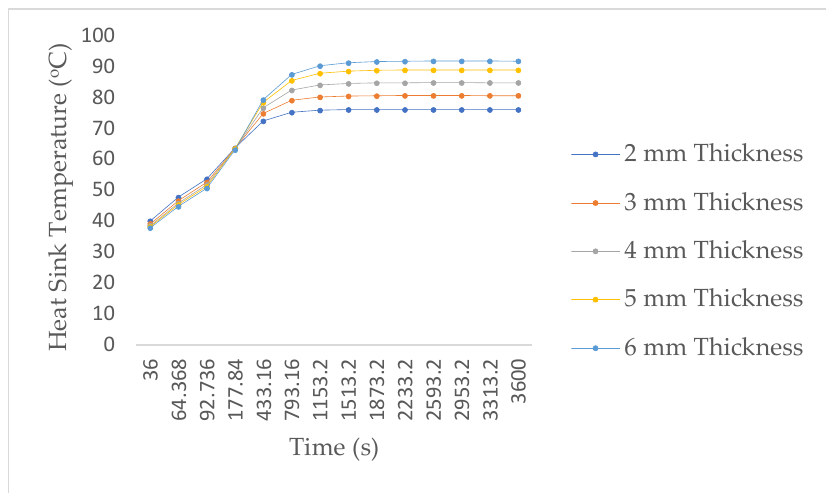
Figure 8. Temperature plot of heat sink at 25.75 W.